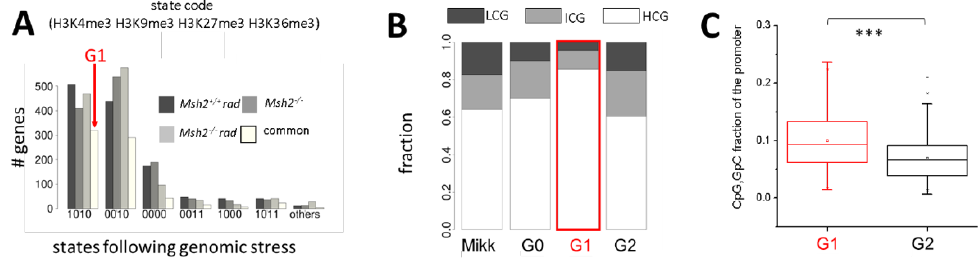
Figure 1. Properties of G1 genes. ( A ) Histone modification state changes of genes exclusively modified by H3K27me3 (0010) in Msh2 +/+ mice following genomic stress. The H3K27me3 targets frequently recruit H3K4me3. Gene set G1 comprises those (0010) genes that show common H3K4m3 recruitment in all mice. ( B ) Genome-wide, about two-thirds of all genes are high CpG (HCG) promoter genes, that is, genes with promoters with high CpG density (Mikk: Mikkelsen et al. [23]). Promotors of G1 genes enrich in HCG promoter genes, while G2 genes comprise higher fractions of intermediate CpG (ICG) and low CpG (LCG) promoter genes compared with the set of all (0010) genes in Msh2 +/+ mice (set G0). ( C ) Boxplot of the CpG, GpC fraction of the promoters of G1 and G2 genes demonstrating significant differences (*** p -value < 1e-11, Kolmogorov–Smirnov test).